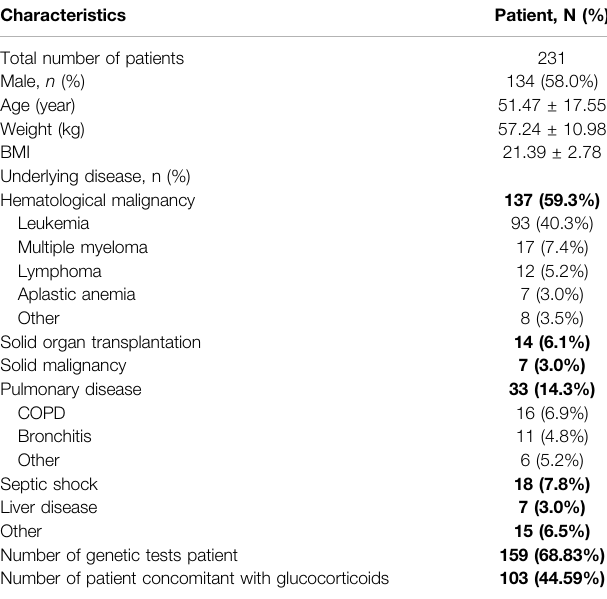
TABLE 1 | Characteristics of 231 patients included in the